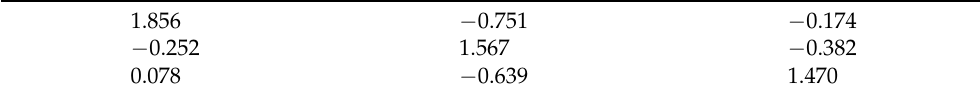
Table 8. CCM found using PSO.